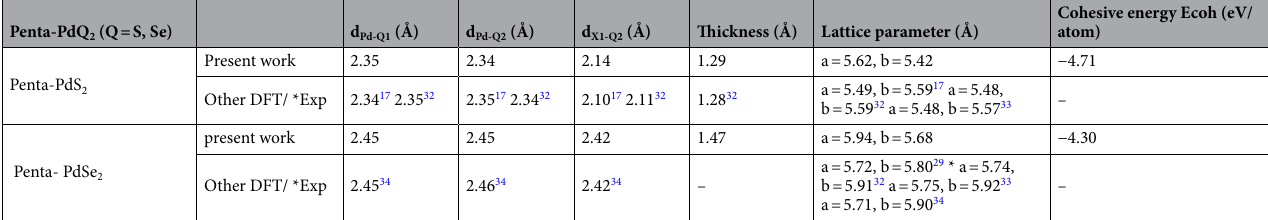
Table 1. The calculated lattice parameter (Å), bond lengths d (Å), thickness t (Å) and cohesive energy E coh (eV/atom) of penta-PdQ 2